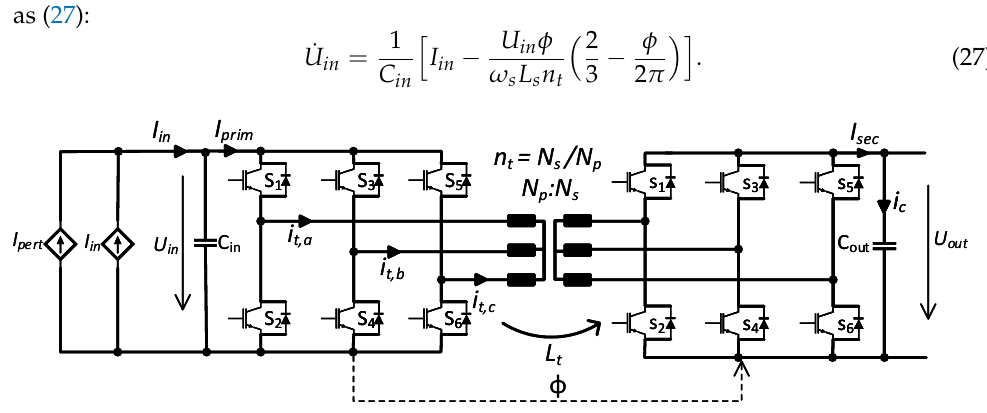
Figure 14. Dual Active